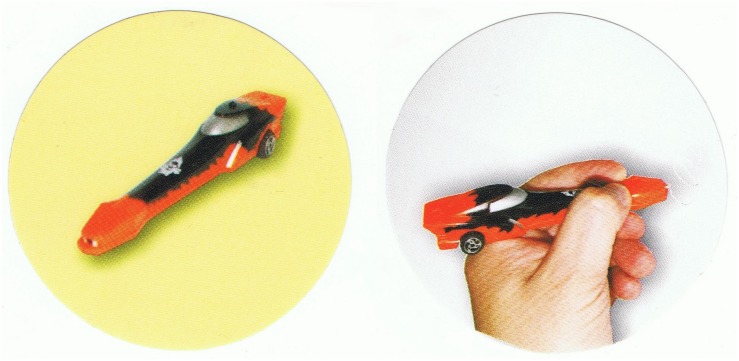
Stickers used in the two-sticker version of the intentionality test.